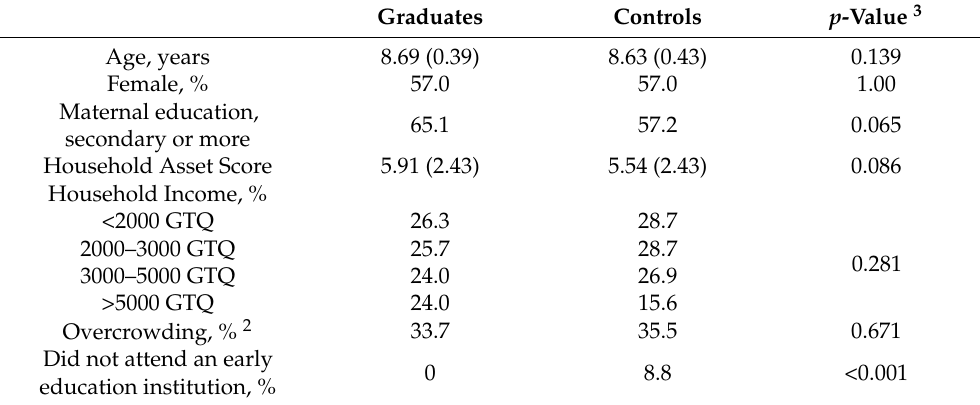
Table 1. Sociodemographic and anthropometric characteristics and test scores of children that received early childhood intervention (“graduates”) vs. age, sex, and location-matched controls 1 .